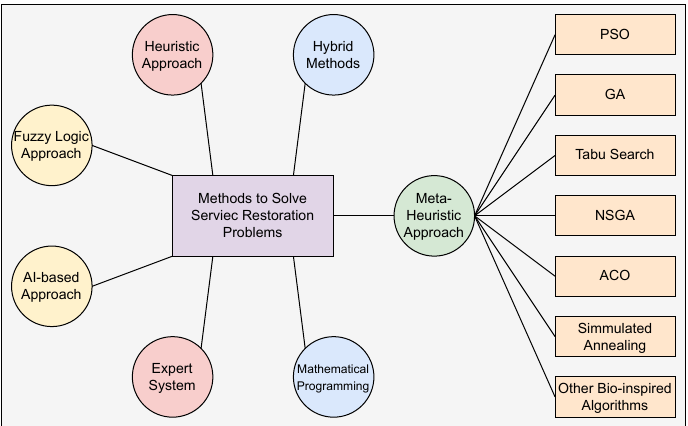
Figure 6. Various methods of solving the service restoration